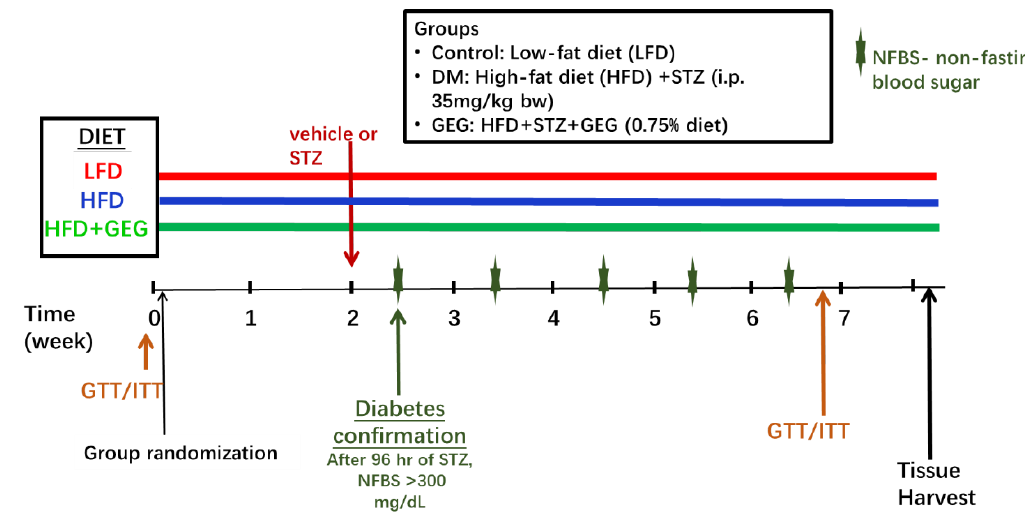
Figure 1. Experimental design describing the three experimental groups, diet assigned to each group, GTT/ITT tests, STZ/vehicle administration, non-fasting blood sugar assessment (NFBS), and tissue collection.